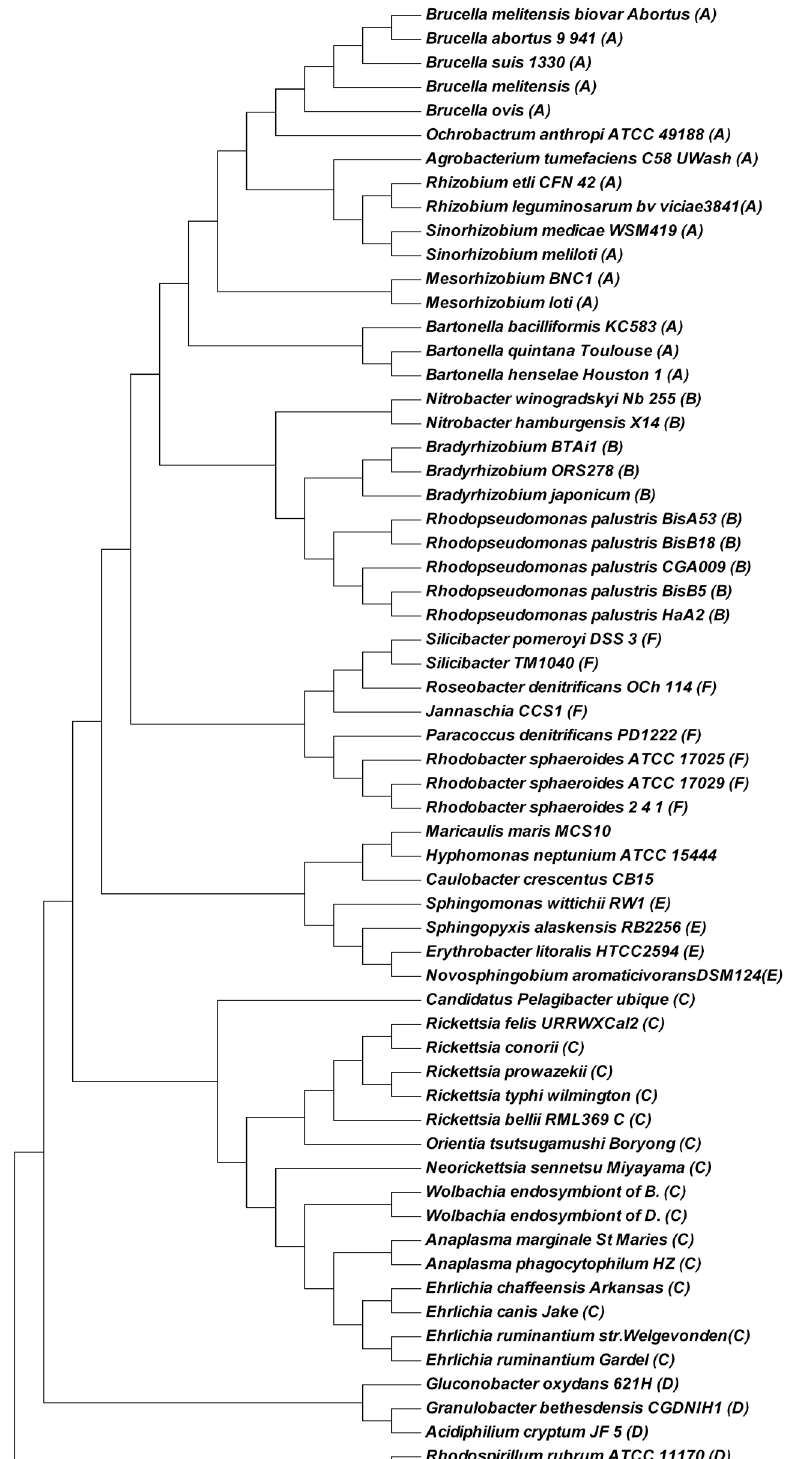
Figure 5. Phylogeny of 62 alpha-proteobacteria using the dynamical language approach with chord distance in the cases K = 5 and 6 based on all protein sequences. The topology of trees obtained by the dynamical language approach with pseudo-distance in [5] and piecewise distance in the cases K = 5 and 6 based on all protein sequences are the same as that in this